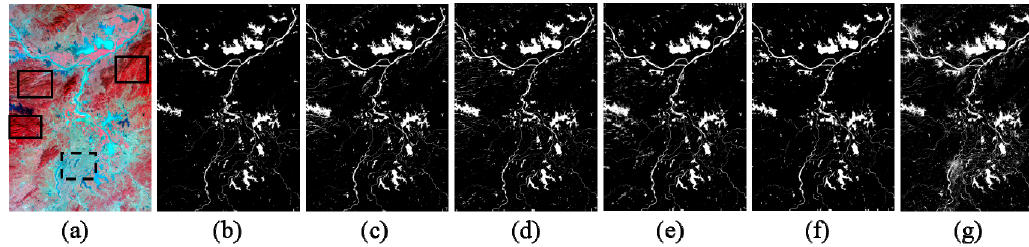
Figure 7. Comparison of the water identification effect of different models in Poyang Lake on 31 December 2016. ( a ) False color composite remote sensing image, and water body identification result by ( b ) the DenseNet, ( c ) the ResNet, ( d ) the VGG, ( e ) the SegNet, ( f ) the DeepLab v3+ and ( g ) the NDWI models. White color indicates the identified water bodies, solid line depicts mountain area, dashed line depicts urban area.